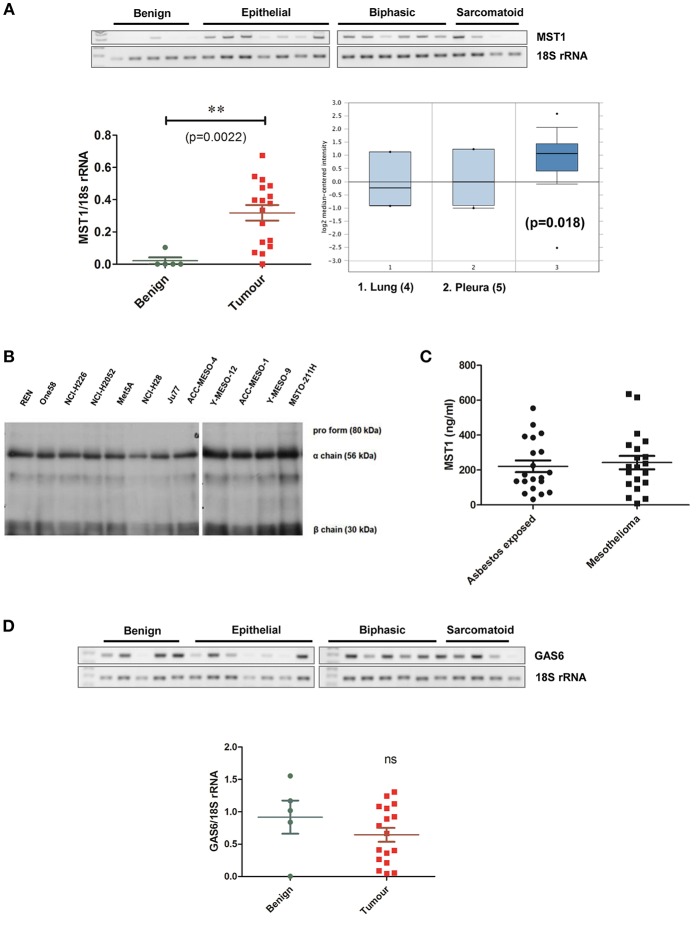
Levels of MST1 are significantly elevated in MPM tissue vs. benign. (A) MST1 is overexpressed in primary MPM vs. benign pleura. Analysis of the Leicester samples showed significant (p = 0.0022) overexpression in tumors (n = 17) vs. benign pleura (n = 5) Statistical significance was obtained using a two tailed Student's t-test with Welch's correction (**p < 0.01). This data was confirmed using Oncomine analysis of the Gordon MPM dataset (n = 49) (37), where MST1 levels were elevated in MPM tumors compared to pleural tissue (p = 0.018). For differential gene expression analysis Oncomine uses two sided Student's t-test (36). (B) MST1 is expressed at protein level in MPM cell lines (n = 12). Western blot demonstrating expression of MST1 at the protein level in MPM cell lines. (C) Serum MST1 levels were unaltered in patients with primary mesothelioma vs. patients with prior exposure to asbestos (n = 20 per group). (D) GAS6 mRNA levels were unchanged in the MPM patient cohort compared with benign pleura. β-actin or 18S rRNA is included as a loading control in appropriate images.